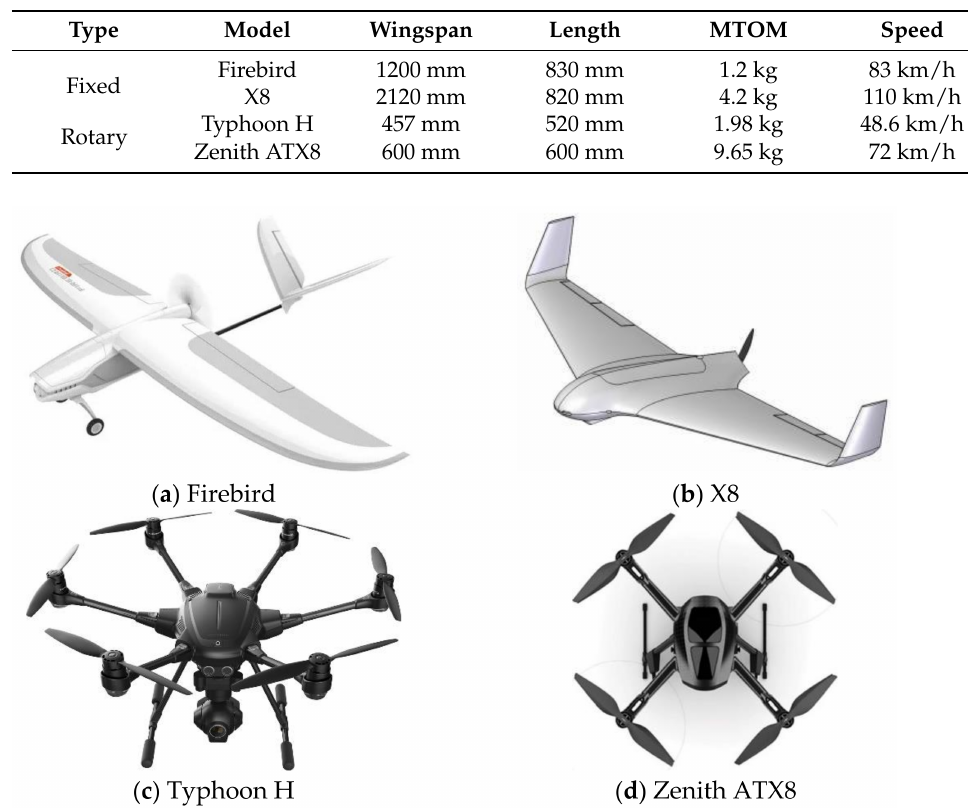
Table 4. UAV parameters for ground impact analysis.